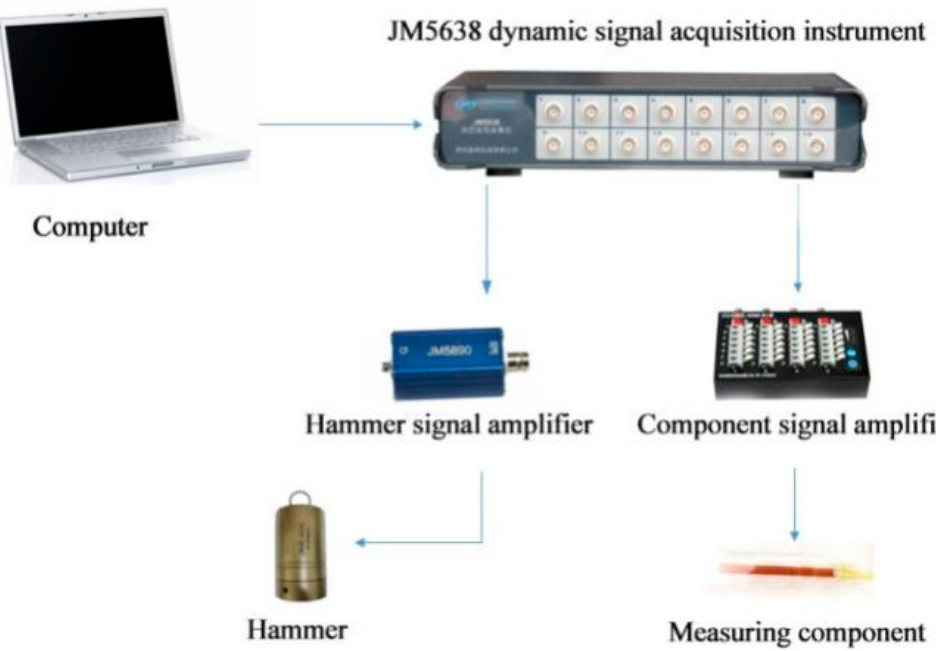
Figure 7. JM5938 dynamic signal test and analysis system.